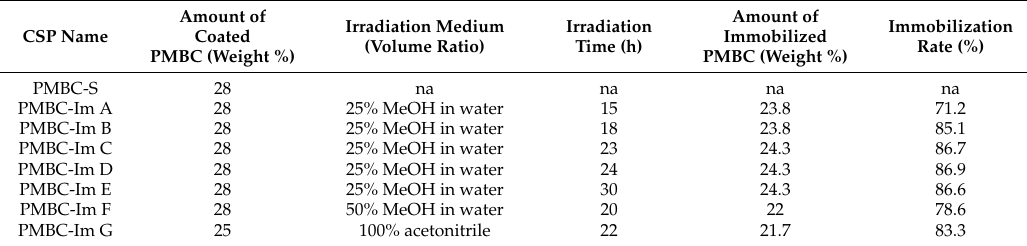
Table 1. Preparation conditions and characterization of the immobilized PMBC-Im CSPs.